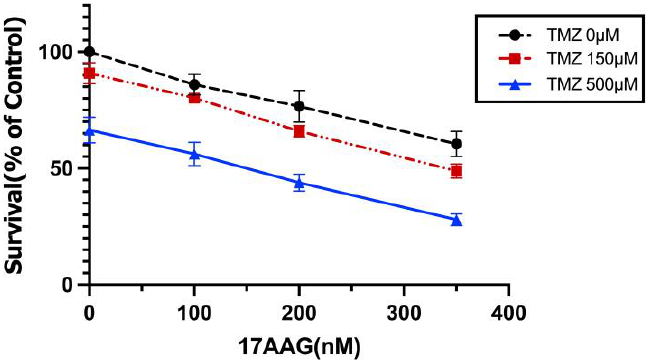
Figure 2. Surviving fraction of 24 h treatment of TMZ combined with 17AAG for T98G cells.